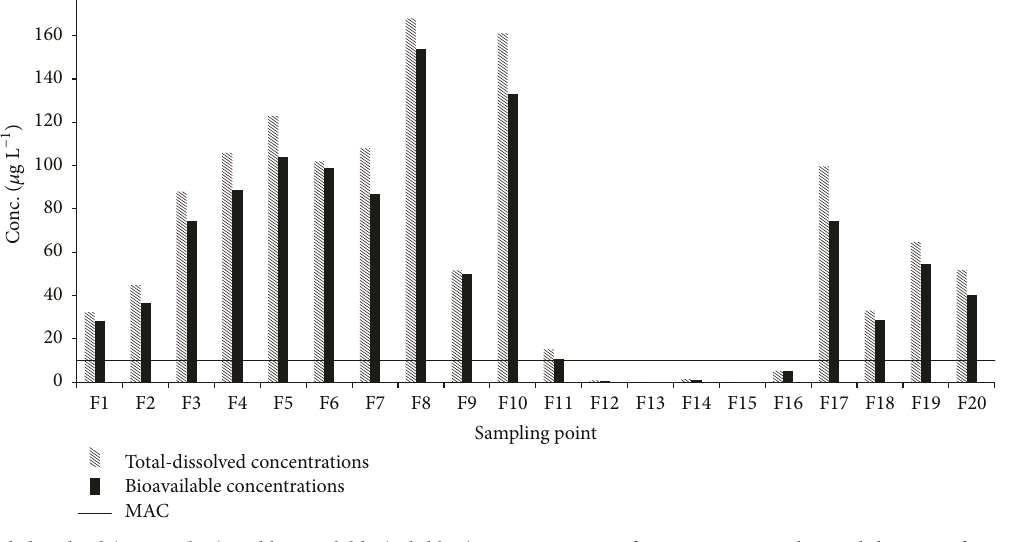
Figure 2: Total-dissolved (pattern bar) and bioavailable (solid bar) concentrations of As in water samples, and the MAC for As in drinking water (horizontal solid line).